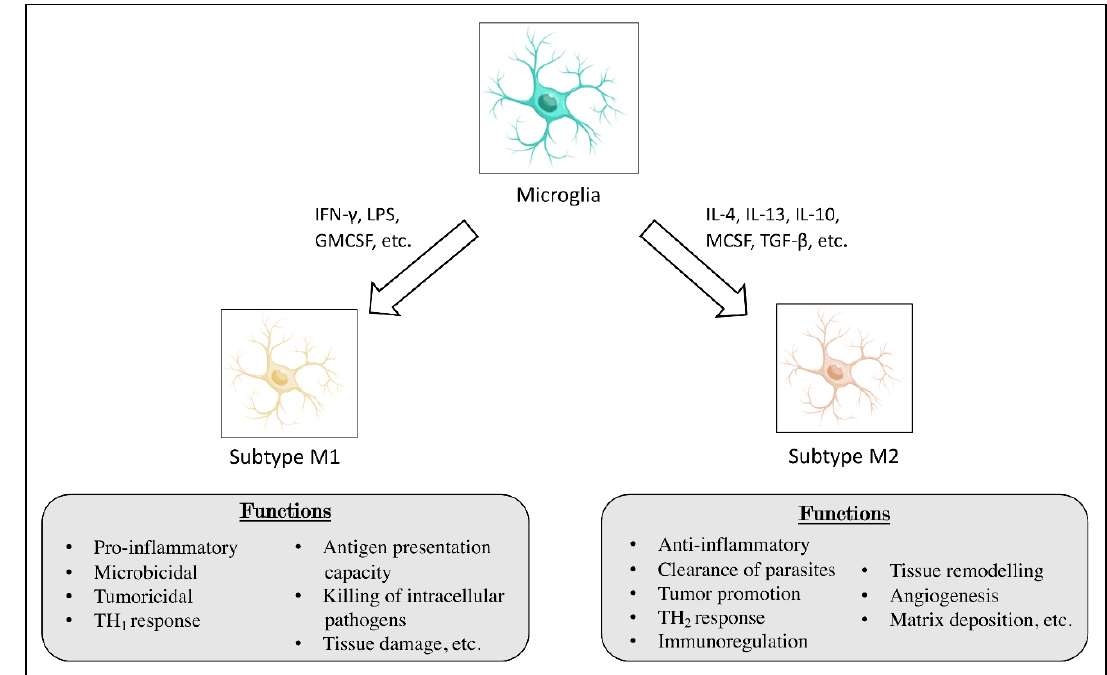
Figure 1. Differentiation of microglia. The figure illustrates the differentiation of microglia into M1 and M2 subtypes, with the related functions for each.